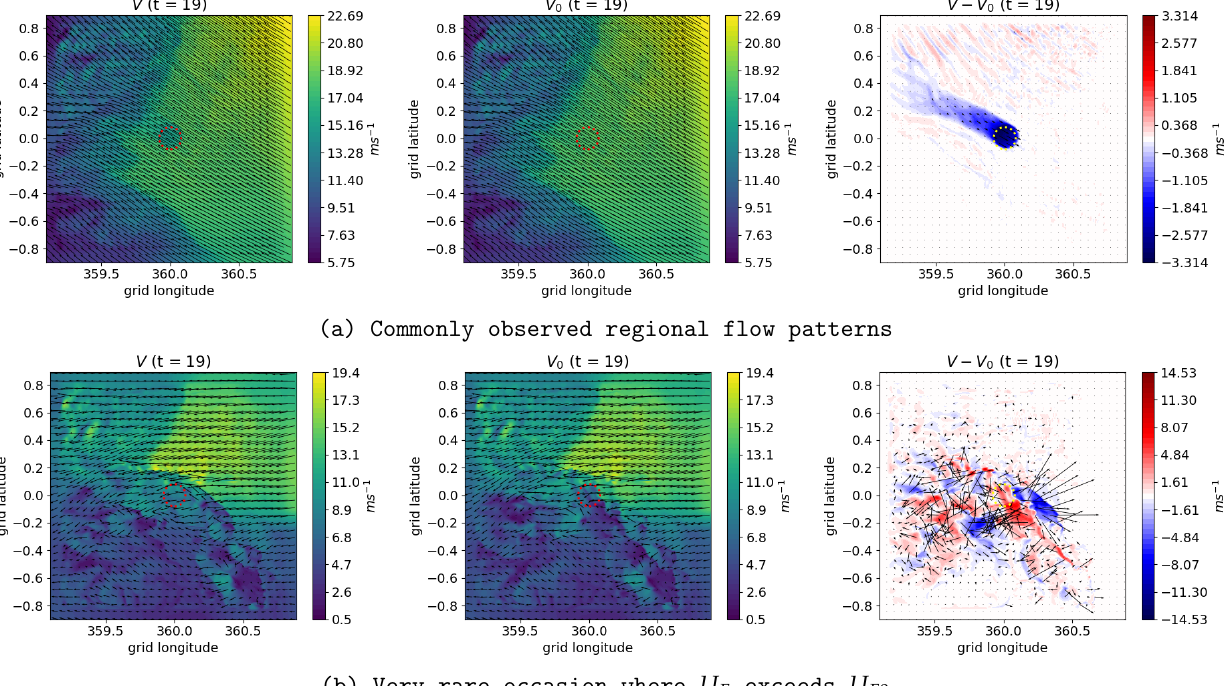
Figure 8. Comparison of hourly averaged regional flow fields: ( left ) For the case with wind farm ( center ) for the case without wind farm ( right ) wind speed difference between the two cases. The wind speed ( V and V 0 for the cases with and without wind farm, respectively) has been averaged vertically from the lowest model level up to the 7th model level (233